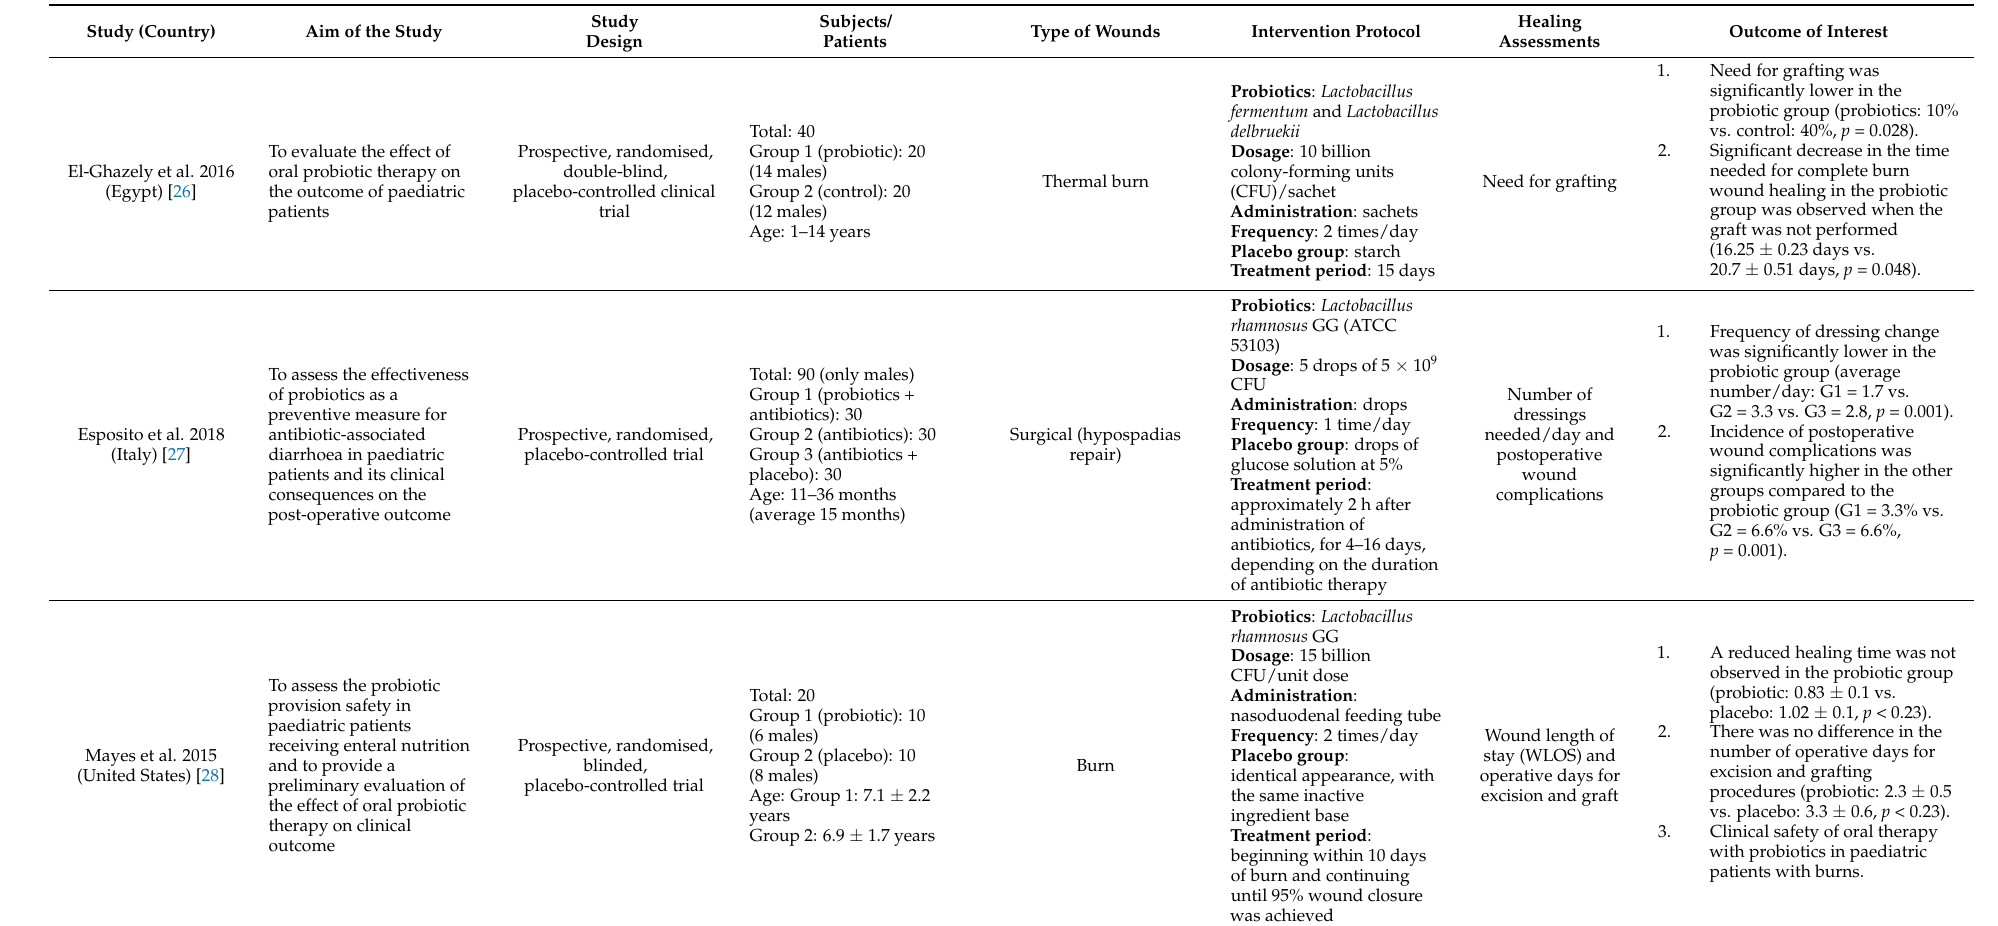
Table 1. Summary of the characteristics and outcomes of the included